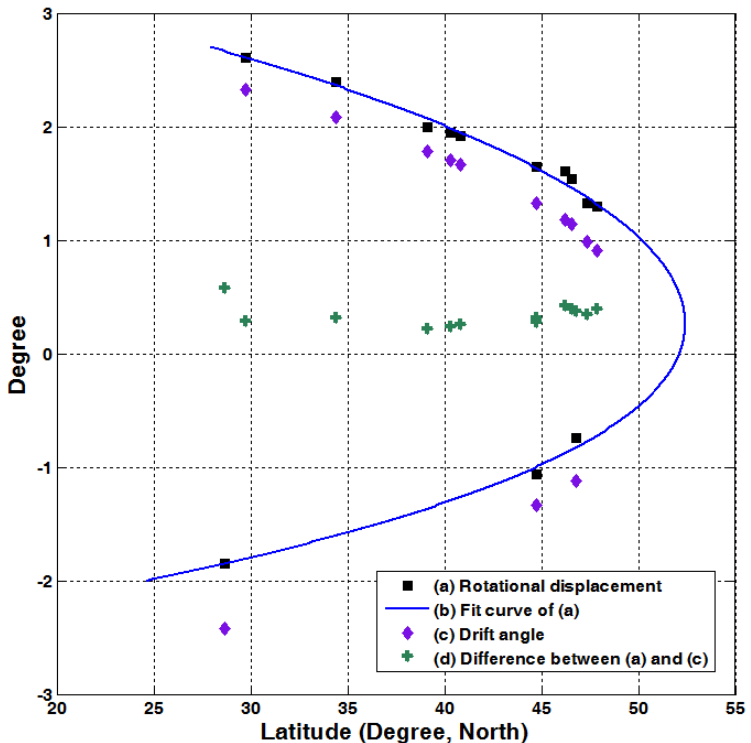
Figure 1. Effect of the drift angle on geolocation as a function of latitudes of images’ NADIR locations. The squares are the rotational displacement angles estimated for 13 ISSAC images; the diamonds are the actual drift angles determined for these images; and pluses are the difference between the two